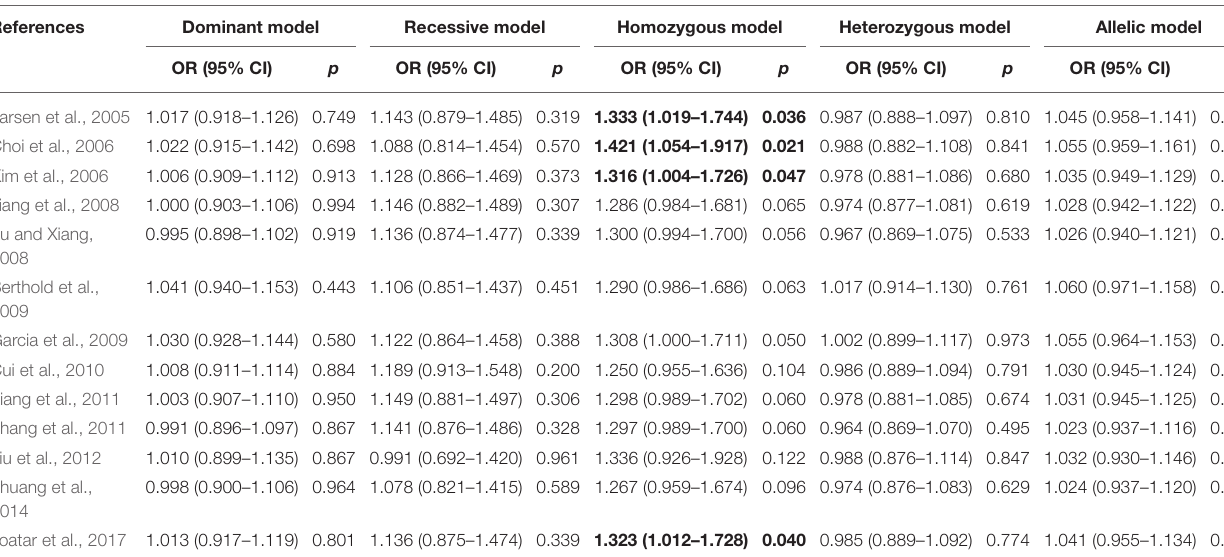
TABLE 3 | Sensitivity analysis by excluding individual study in each genetic